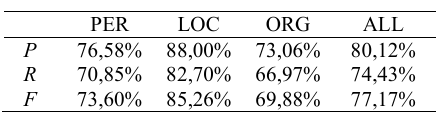
Table 5. Precision and Recall after running Algorithm 2 in the three modes on the dataset D